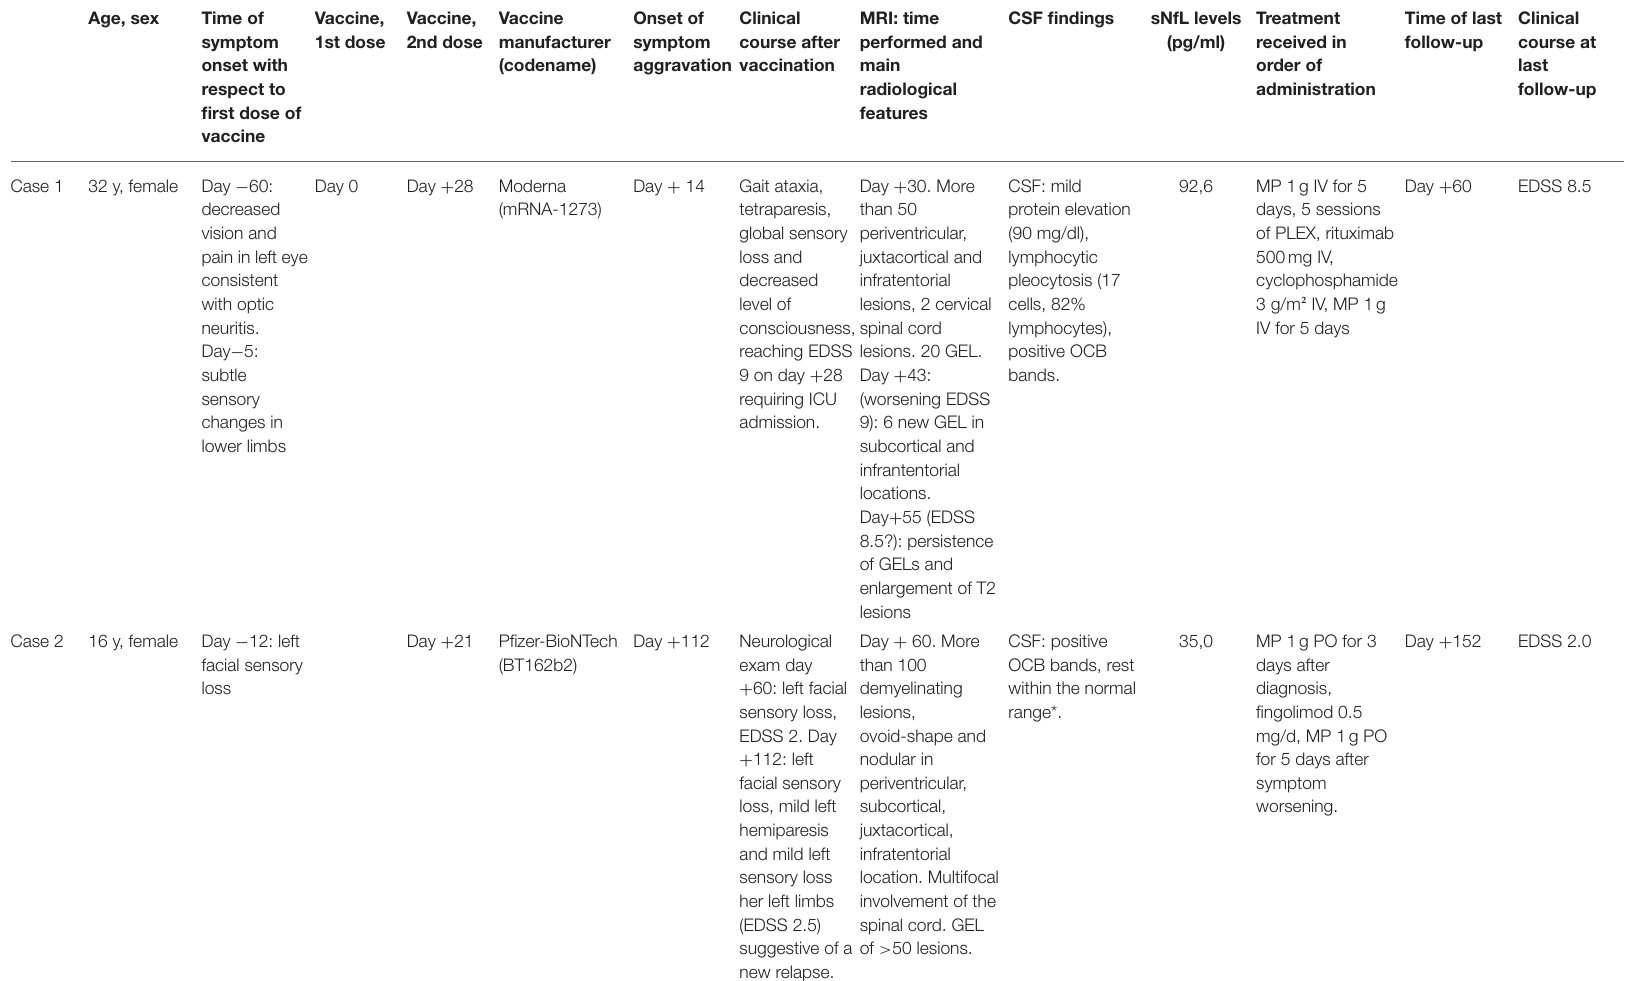
TABLE 1 | Summary of the four cases showing the main clinical and radiological features in chronological order with respect to the day of